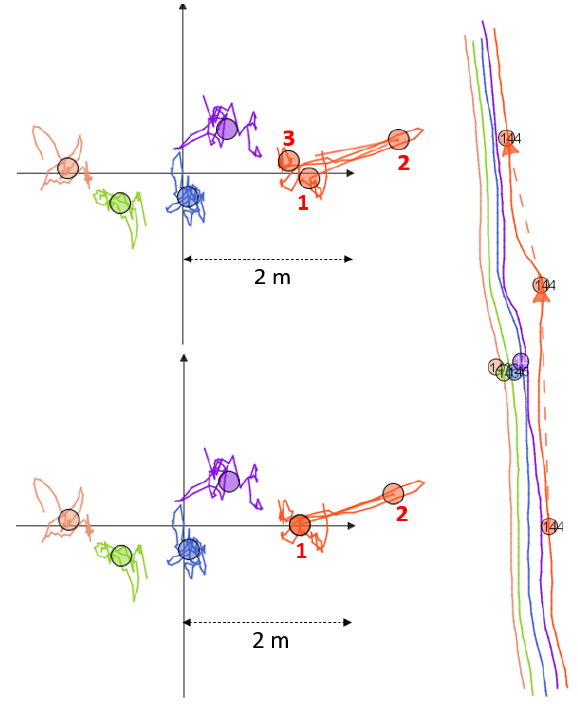
Figure 6. A group of 5 pedestrians is analyzed. The red colored person changes its position twice (back and forth). Left: the resulting relative movements and intra-group position changes by the sliding window (top) and the clustering variant (bottom). Right: The backtransformed changes into the original movement data.